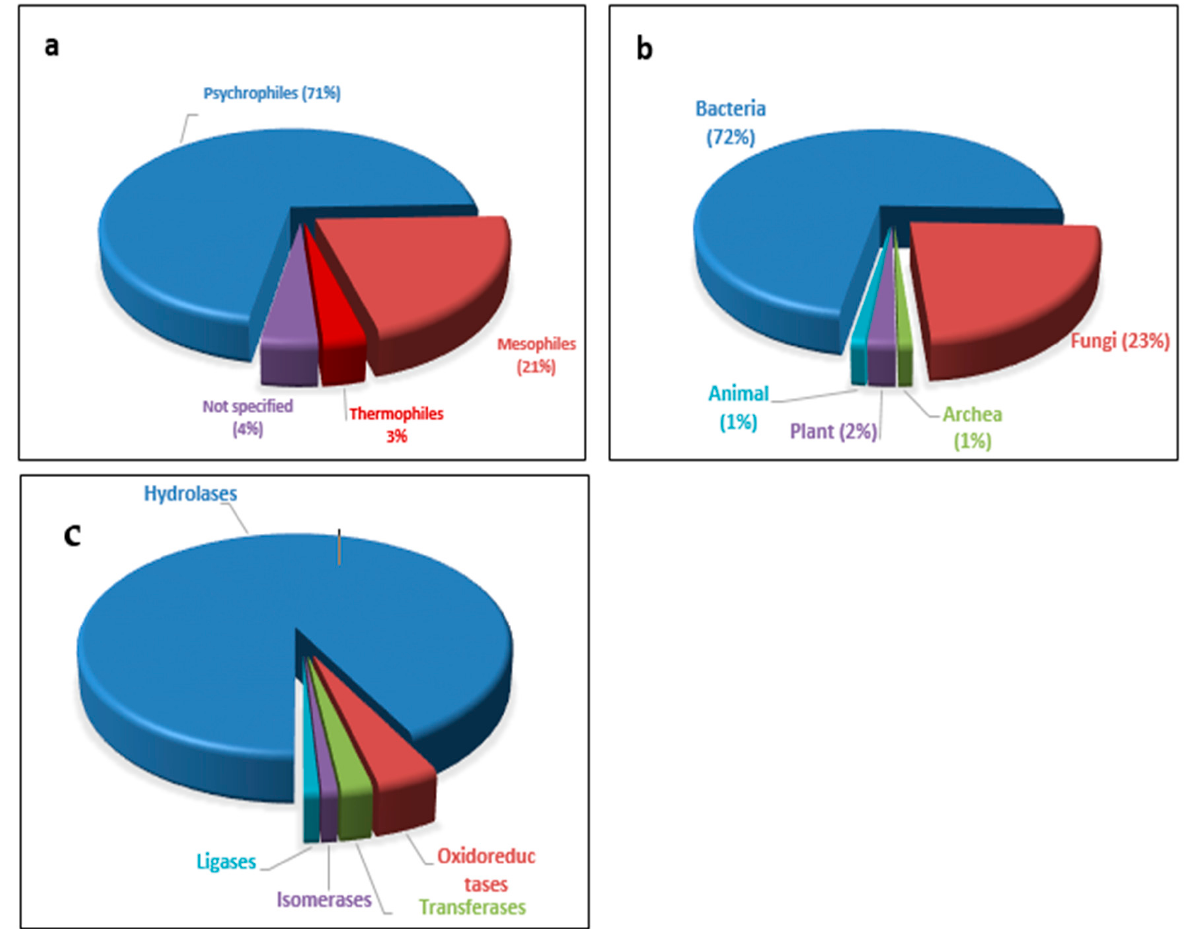
Figure 1. Distribution of cold-active enzymes ( a ) based on organism nature, ( b ) on organism type, ( c ) and on cold-active enzymes reported.